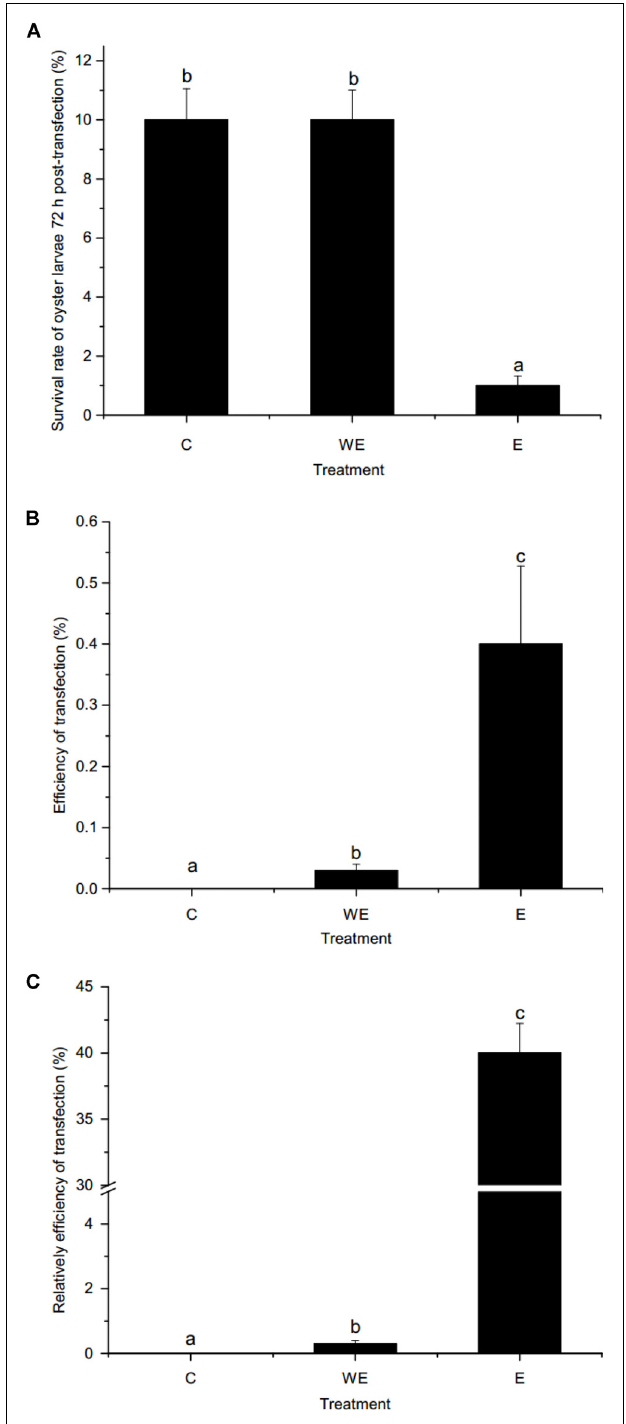
FIGURE 4 | Survival rate and transfection efficiency using piggyBac system in oyster larvae. (A) Survival rate of oyster larvae 72 h post-transfection; (B) efficiency of transfection; (C) relative efficiency of transfection. C, non-transfected control group. WE, sperm-mediated transfection without electroporation. E, sperm-mediated transfection with electroporation. Data are shown as the means ± SEM (standard error of mean, SEM), n = 3. Different letters indicate statistically significant differences ( p <